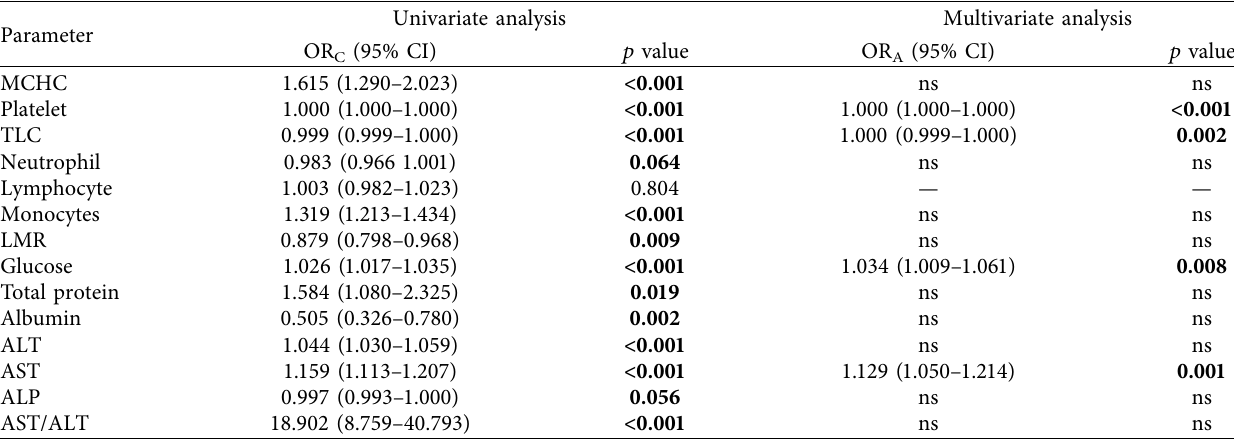
Table 4: Binary logistic regression analysis for laboratory parameters in overall dengue-positive study participants.